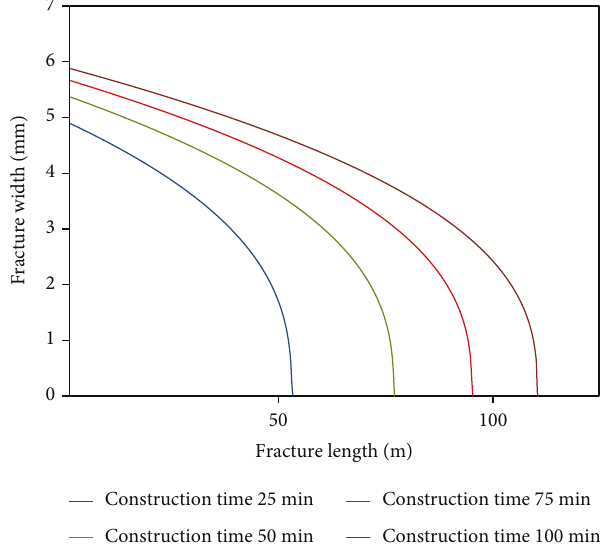
Figure 10: Fracture morphology of carbon dioxide foam fracturing under di ff erent construction times (displacement 4.0m 3 /min).